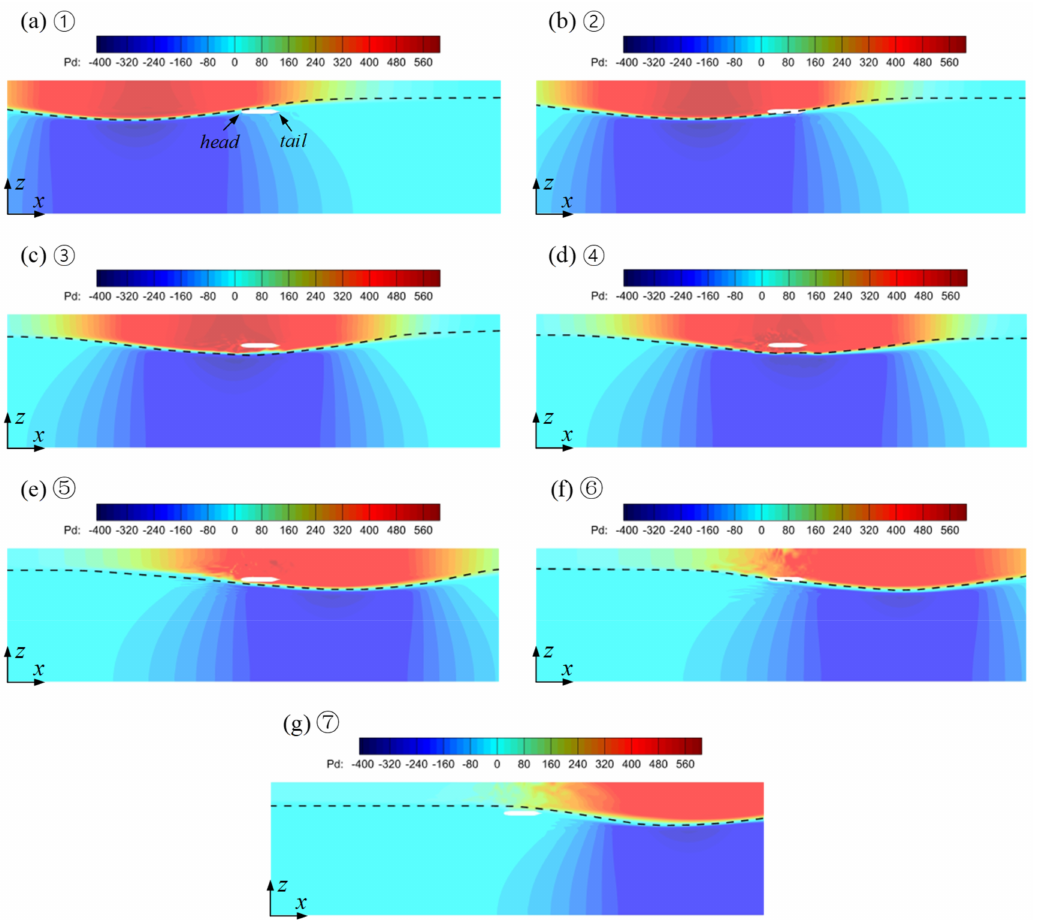
Figure 12. Dynamic pressure at key times of 1 (cid:13) – 7 (cid:13)